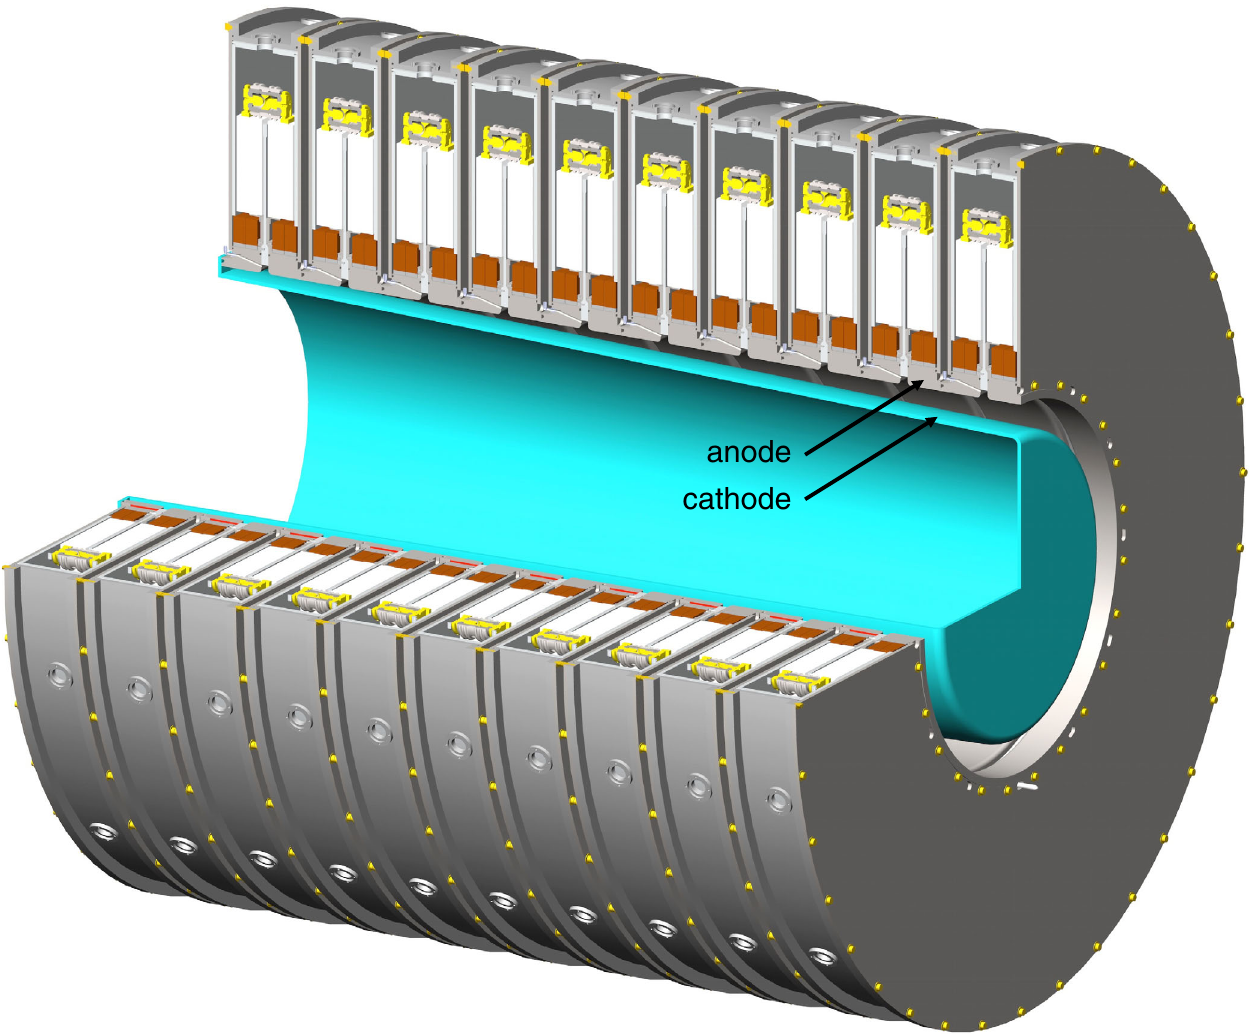
FIG. 2. Cross-sectional view of a three-dimensional model of a ten-cavity 2-m-diameter LTD module. The anode and cathode are the electrodes of the module ’ s internal water-insulated coaxial transmission line. Each Z-300 module includes 33 such